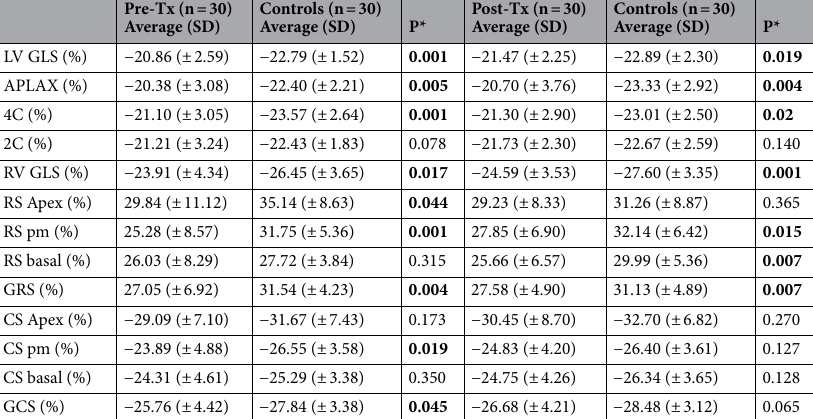
Table 5. Two-D Speckle Tracking parameters. Statistical significance p < 0.05. LV GLS, LV global longitudinal strain; APLAX, apical long-axis view; 4C, apical four chamber view; 2C , apical two chamber view; RV GLS, RV global longitudinal strain; RS, radial strain; Pm, papillary muscle level; GRS, global radial strain; CS: circumferential strain; GCS, global circumferential strain; *Students